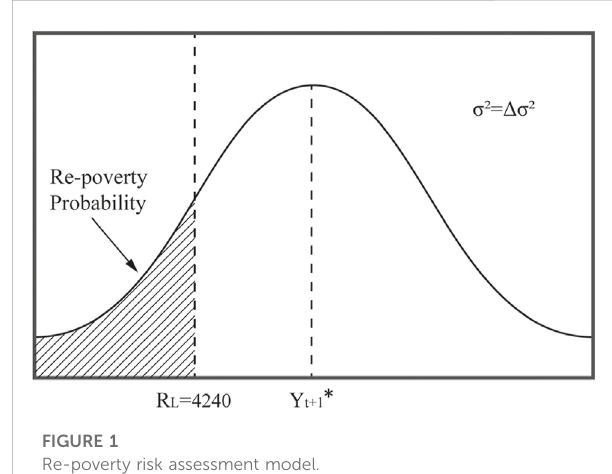
Re-poverty risk assessment